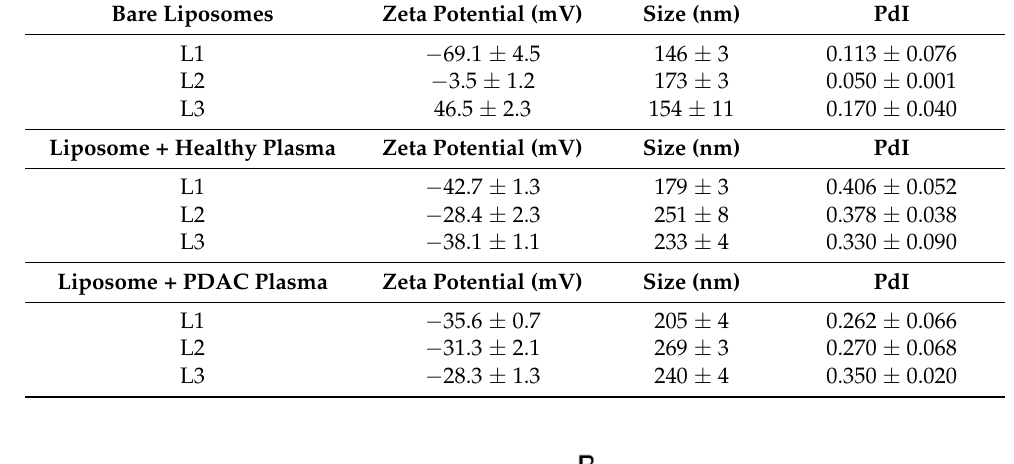
Table 1. Zeta potential, size and polydispersity index of bare liposomes and their counterparts after exposure to human plasma from healthy donors and pancreatic ductal adenocarcinoma (PDAC) patients.